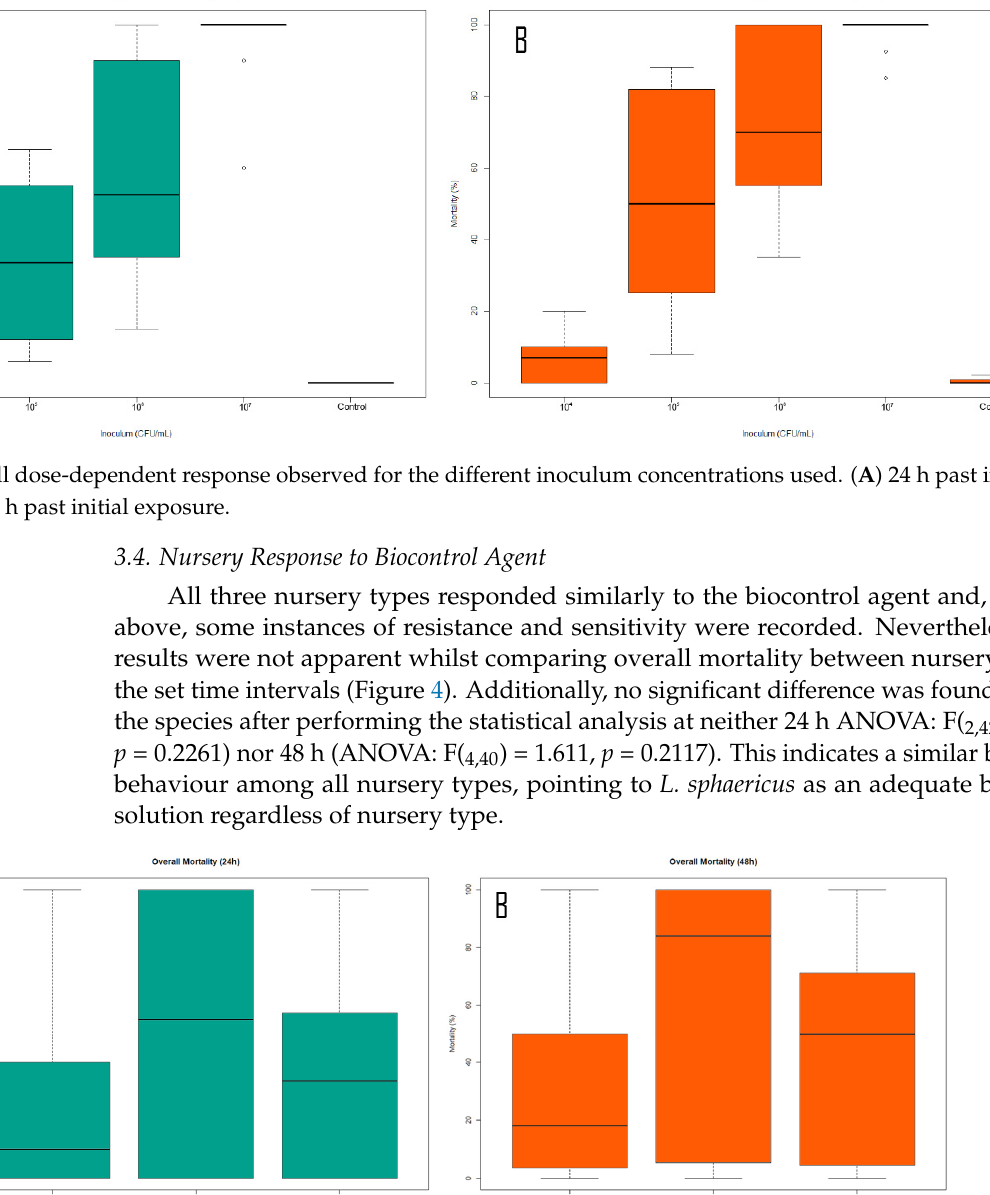
Figure 2. Dose-dependent responses of the different Aedes nurseries when exposed to the different inoculum concentra- tions used at the set time intervals. ( A ) Aedes albopictus nurseries (24 h post inoculation). ( B ) Aedes albopictus nurseries (48 h post inoculation). ( C ) Aedes aegypti nurseries (24 h post inoculation). ( D ) Aedes aegypti nurseries (48 h post inoculation).